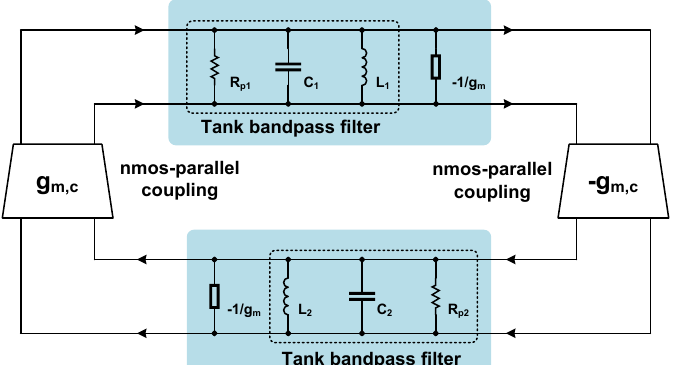
Figure 3. A simplified block diagram of the PQVCO where two oscillator cores are coupled with each other through transconductance ( g m , c )